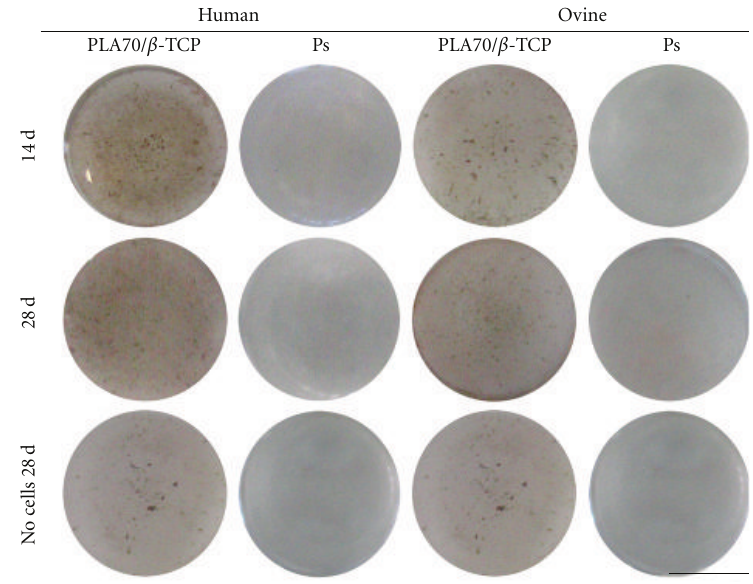
Figure 5: Von Kossa staining of human and ovine adipose stem cells at 14 and 28d time point. Scale